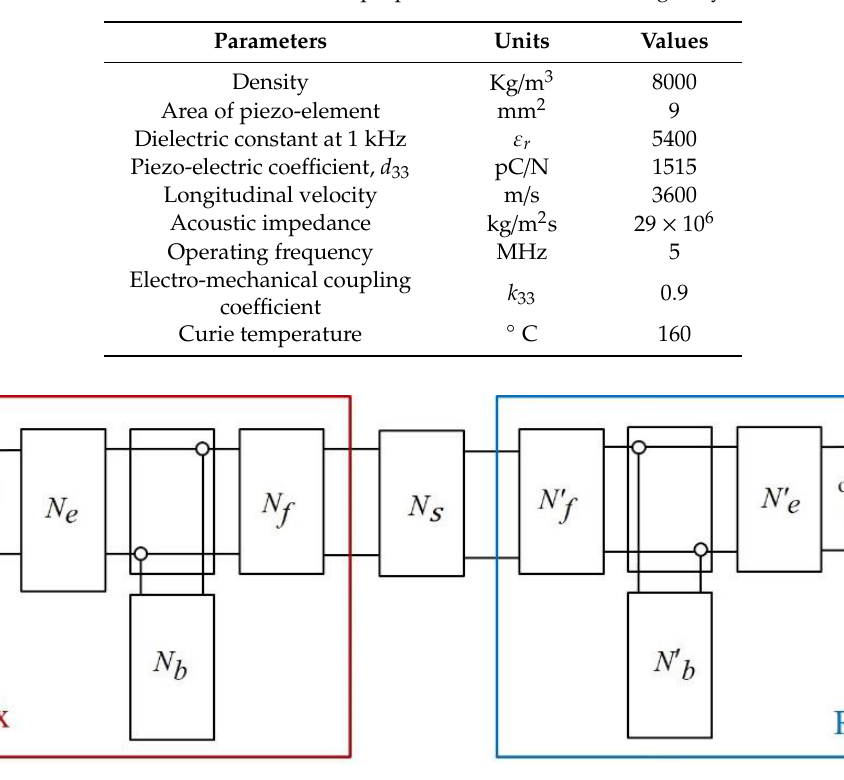
Figure 6. Schematic diagram of the modified KLM model for the through-transmission method.